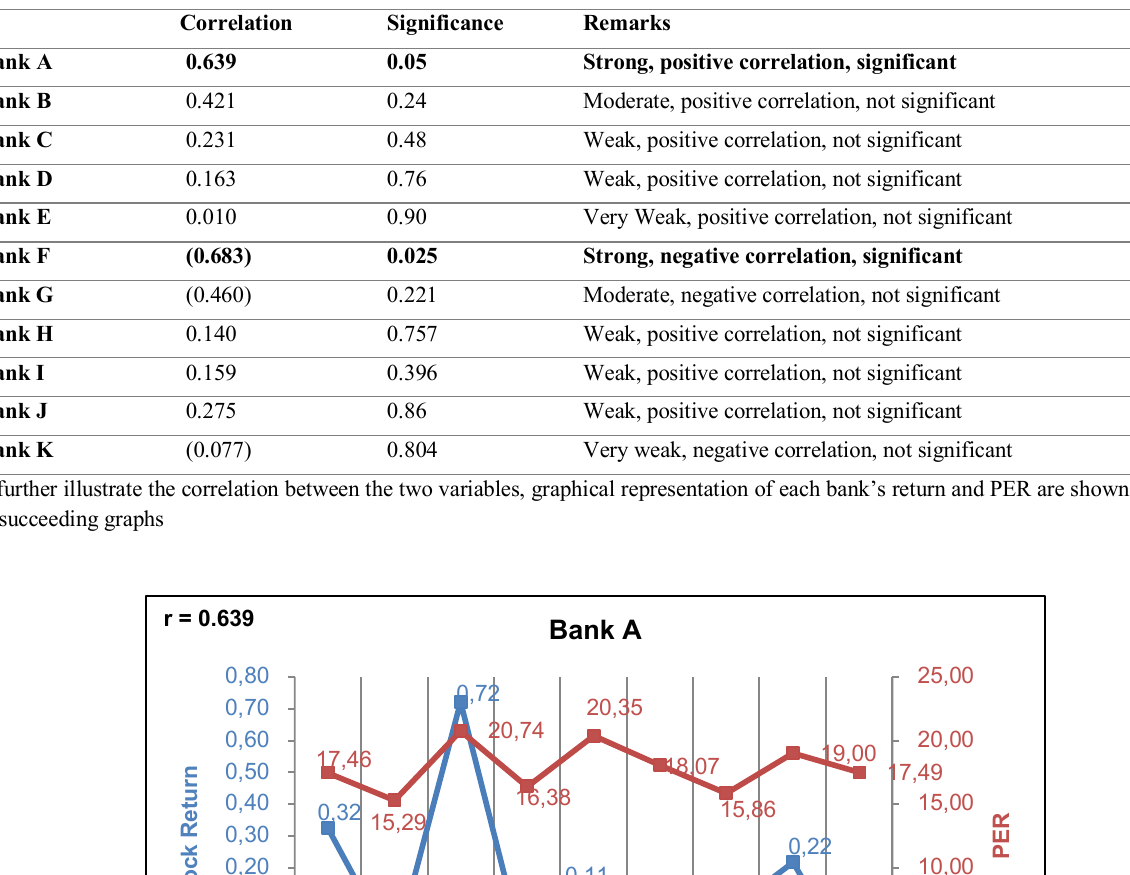
Table 2: Correlation Coefficients (p > 0.05 is not significant)